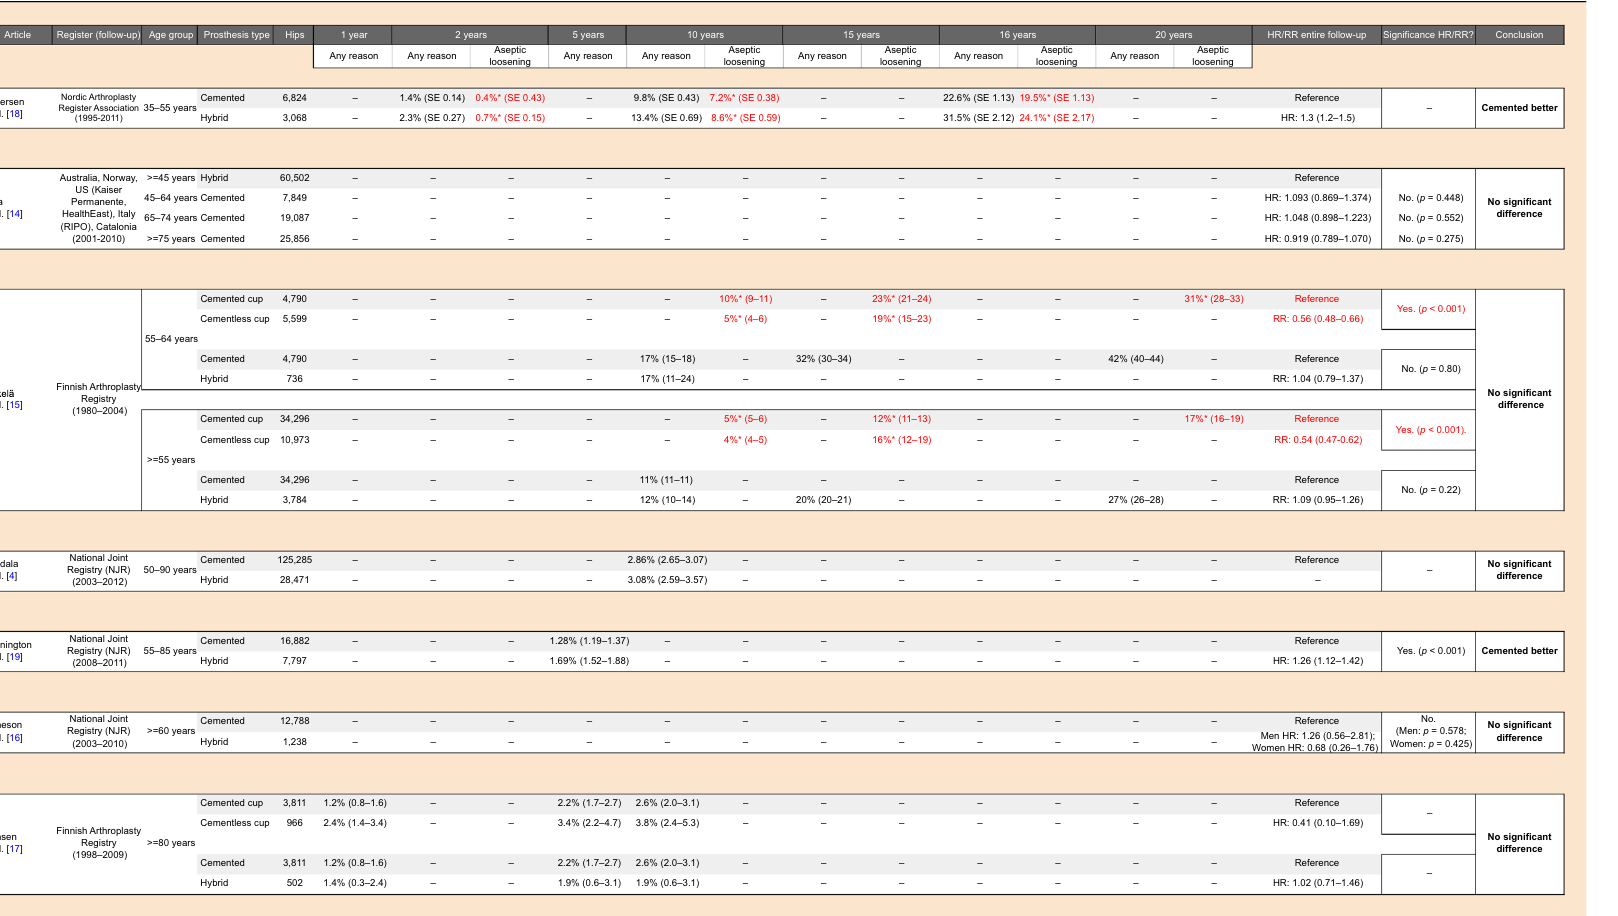
Table 1. Comparison of revision rates for cemented and hybrid total hip arthroplasty for primary osteoarthritis, categorised by age group.